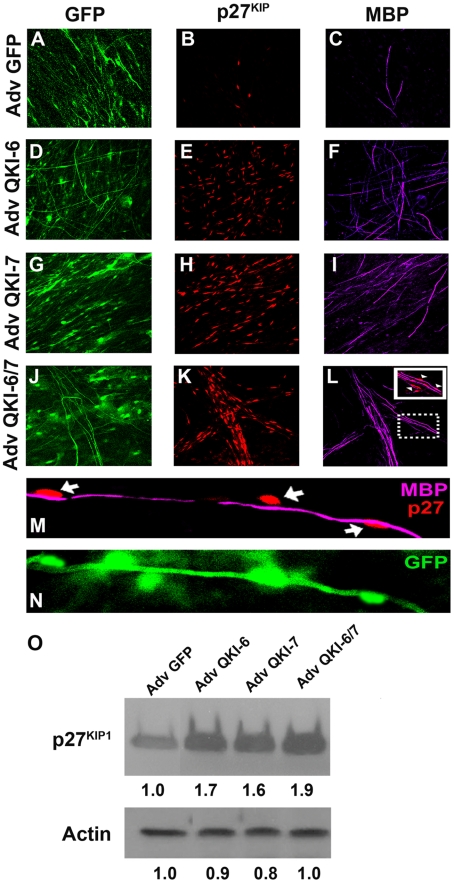
QKI-6/7 transduced Schwann cells/neurons co-cultures display elevated nuclear p27KIP1 staining and directional MBP nerve fibers.Co-cultures of Schwann cells/neurons were transduced with adenoviruses coding for GFP (A, B and C), QKI-6 (D, E and F), QKI-7 (G, H and I), or the combination of QKI-6 and QKI-7 (J, K and L). After infection, co-cultures were allowed to myelinate for 5 days with ascorbic acid. Cells were immunostained with anti-p27KIP1 antibodies (red), anti-MBP antibodies (purple) and visualized by fluorescence confocal microscopy. The green cells denote infected Schwann cells as well as infected axons. Ectopic expression of QKI-6 (E), QKI-7 (H) and QKI-6/7 combination (K) activate the expression of p27KIP1 in the nucleus of Schwann cells. Schwann cells are in the vicinity of MBP+ axons fibers (F, I and L). The inset (L) is an image showing a merge from p27KIP1-positive Schwann cells and MBP-positive axons (arrowheads). (M) This image shows the double staining for p27KIP1 (red) and MBP (purple) from a combined infection by QKI-6 and QKI-7 adenoviruses and demonstrate that p27KIP1 Schwann cells are associated with MBP-positive axonal internodes (arrows). (N) Denotes the green fluorescence of the GFP-positive cells of panel M. (O) Schwann/DRGN co-cultures infected with control or the indicated QKI adenoviruses were lysed and the proteins analyzed by immunoblotting for p27KIP1 and β-actin to ensure equal loading. The relative band intensities quantified by densitometry are indicated below.